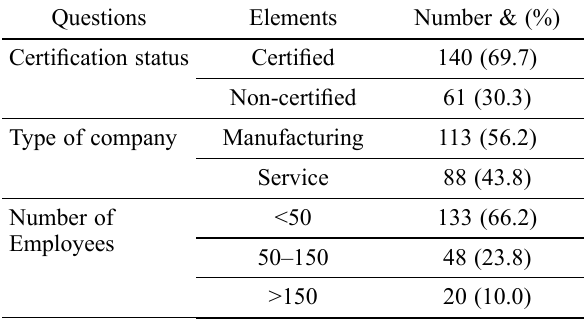
Table 2. Distribution of company (according to type &